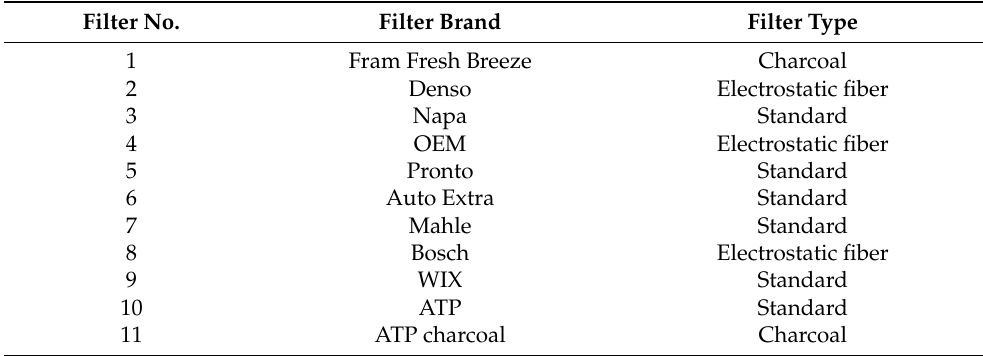
Table A1. A list of the vehicle cabin filters for evaluation in this study. Filter